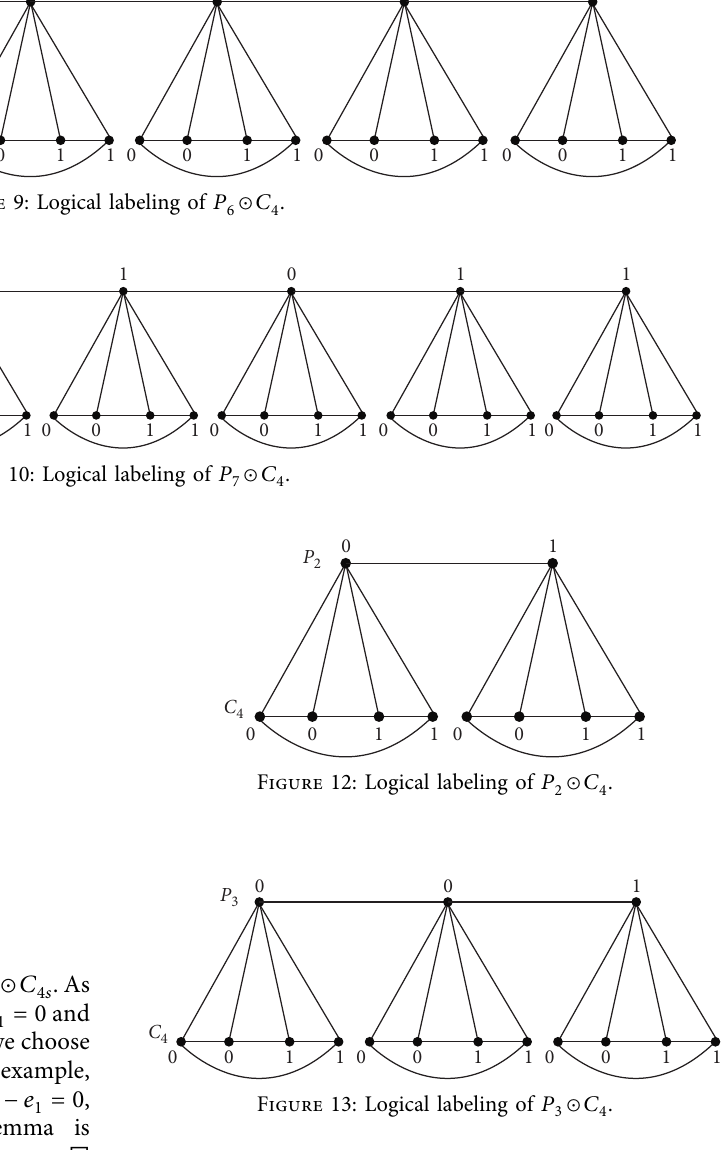
Figure 13: Logical labeling of P